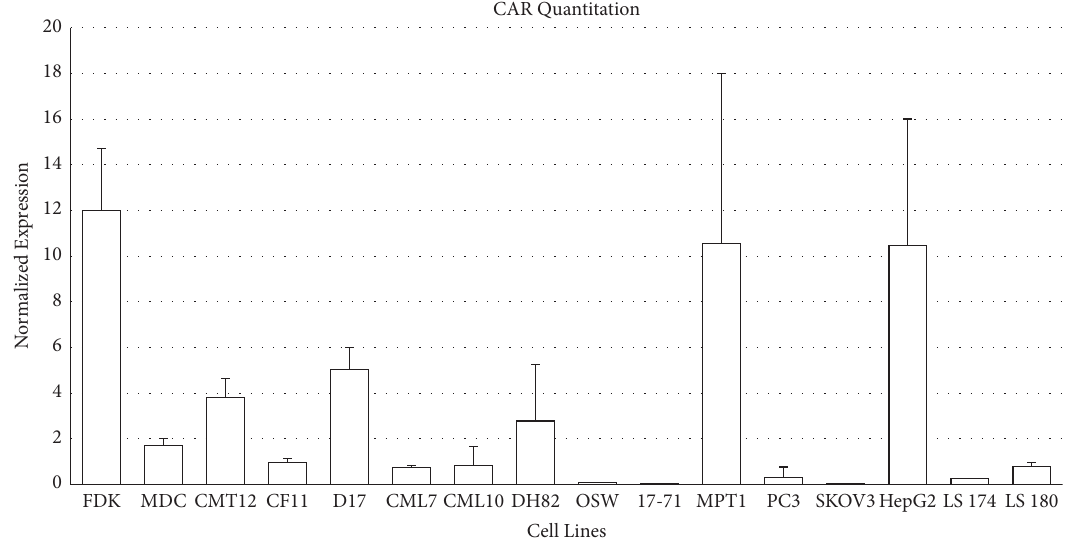
Figure 5: Quantitative RT-PCR analysis of CAR mRNA in canine and human cell lines using specifc primers. CAR expression levels were normalized by the comparative ΔΔ Ct method. Δ Ct values for each sample were calculated by normalizing to beta-actin as the normalization control. ΔΔ Ct values were calculated using the mean of Δ Ct values of all samples as a reference control. Te error bars represent standard deviation. Te results presented here are the average of three independent